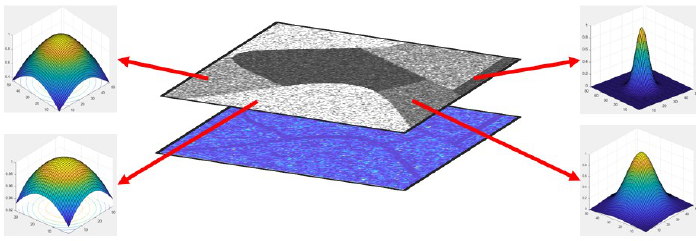
Figure 5. Homogeneous region smoothing